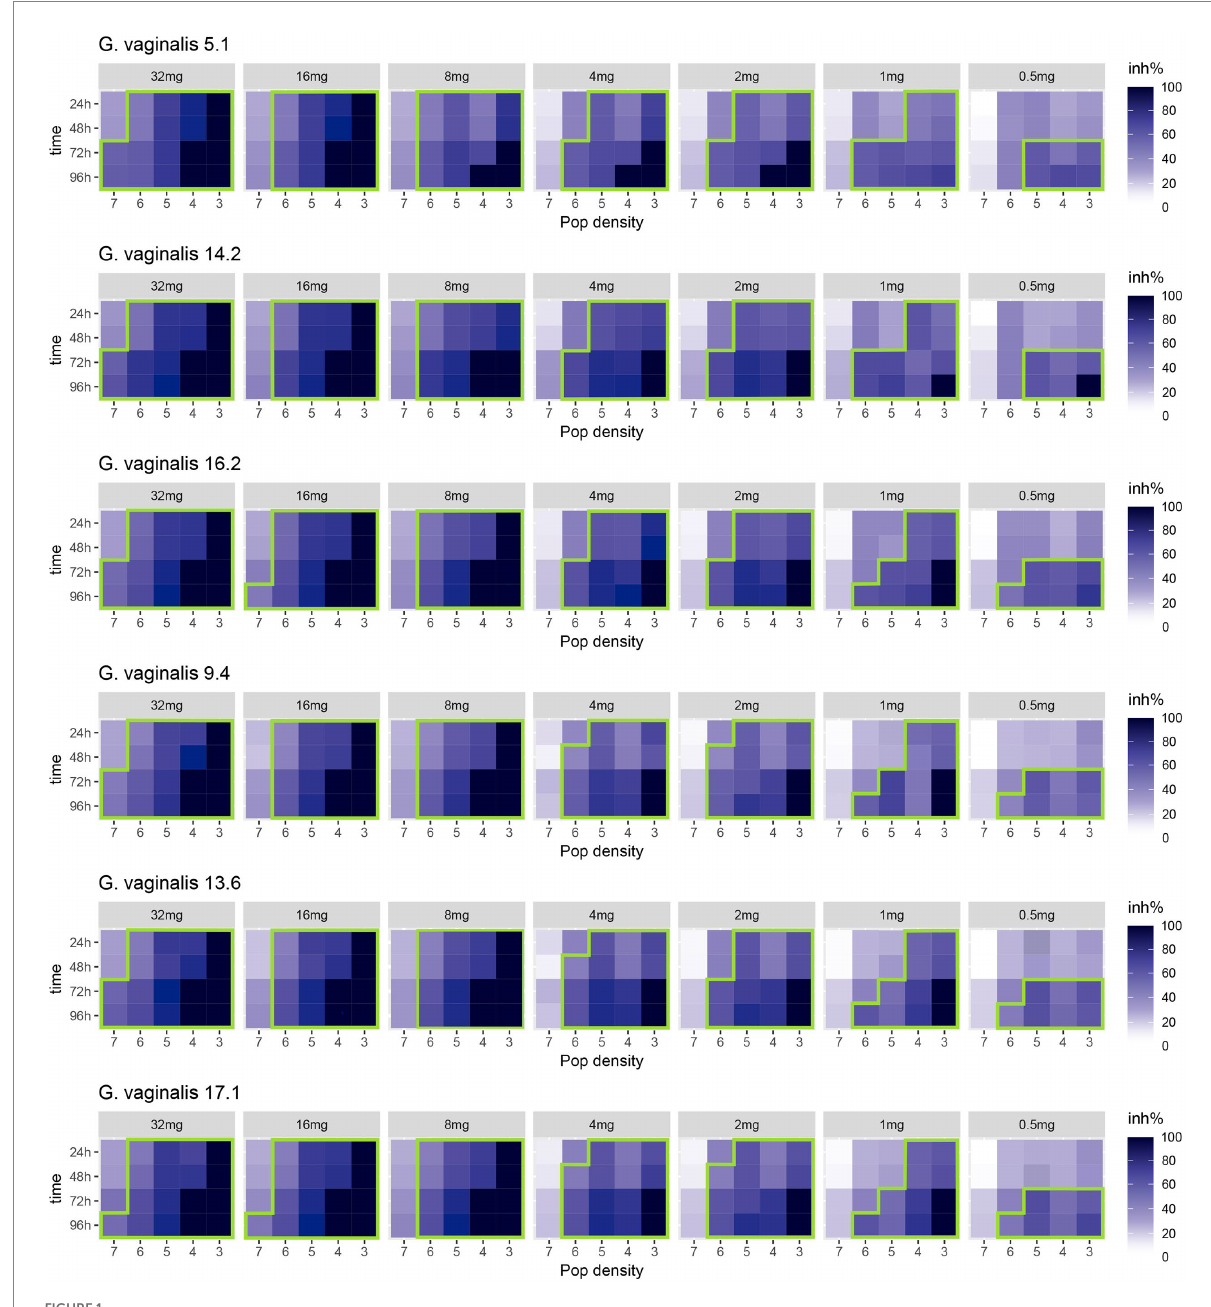
FIGURE 1 Heatmap of the inhibition rate percentages (inh%) displayed over time (from 0 h to 96 h) by presumptive Gardnerella vaginalis 5.1, 14.2, 16.2, 9.4, 13.6, 17.1 clinical isolates, tested at different initial cell densities (from 7 log to 3 log units), after treatment with different concentrations (32, 16, 8, 4, 2, 1, and 0.5 mg/ml) of bovine lactoferrin (MTbLF). The colours of the scale bar represent the inhibition rate percentage (inh%) in the range from 0 to 100%. The green line surrounds the inhibition rate percentages (inh%) equal to or greater than